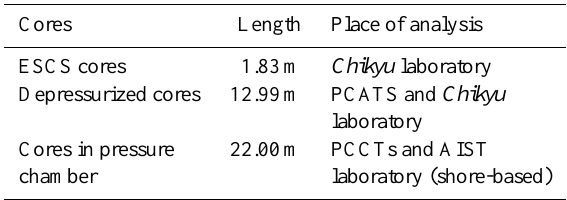
Figure 5. Schematic flow of the onboard core processing for Exp. 802. The obtained samples were processed in three di ff erent schemes. The majority of well-pressure-preserved cores were stored in pressure vessels for more detailed analysis on